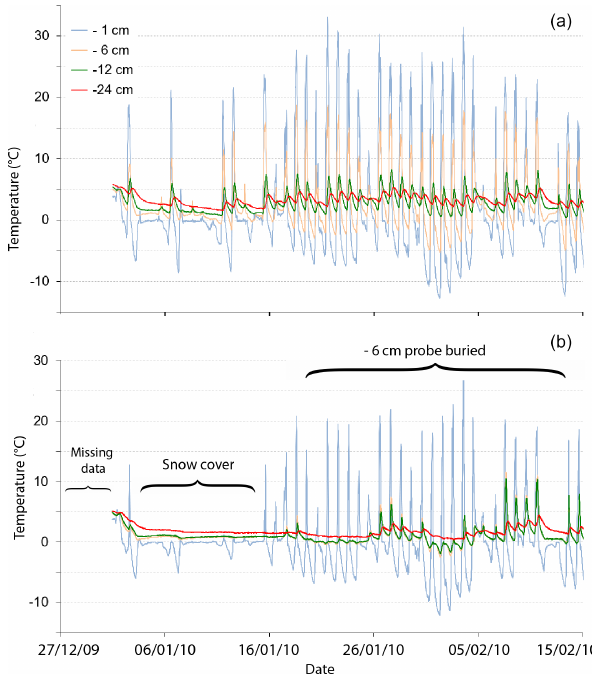
Figure 2. Example of raw temperature series (one measurement every 10min). (a) Typical soil temperature series recorded with four probes at different depths (from south-facing uphill location; timescale as in b ). (b) Example of soil temperature series (from south-facing downhill location) biased because of climatic condi- tions (snow cover) and/or buried or loosened probes. A full year of temperature measurements is shown in Fig. S1. High temperature values are observed at − 1cm even in winter when the black marls heat radiatively during sunny